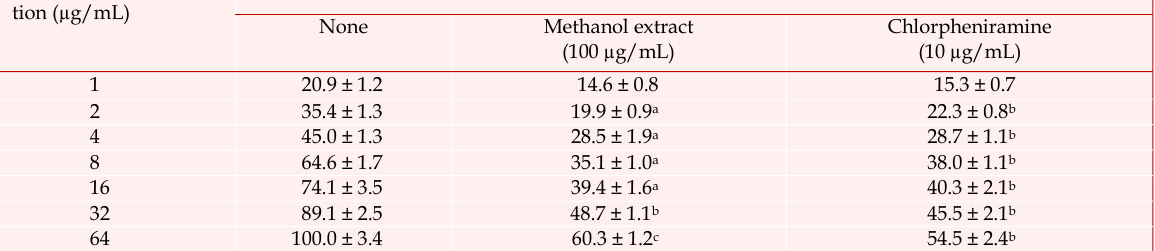
Effect of methanol extract of Stephania glabra on histamine-induced contraction in isolated goat tracheal chain